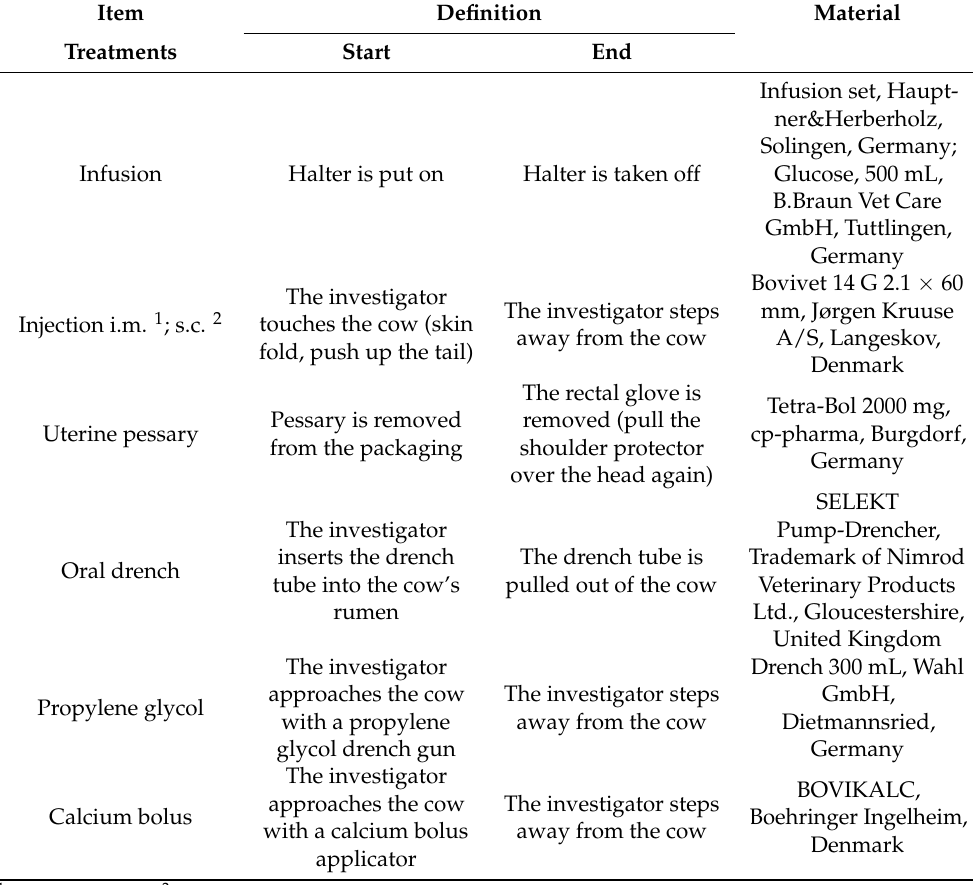
Table 2. Definition of start and end points for various animal treatments, including the necessary